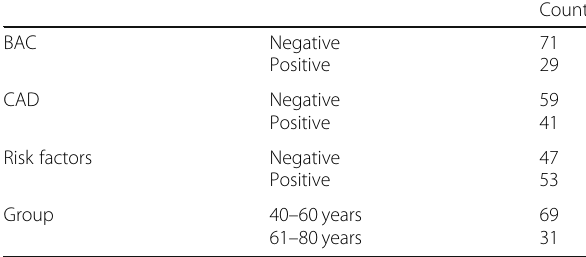
Table 1 Data description of the cases